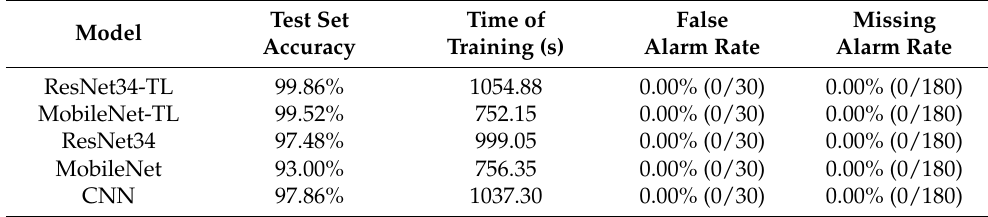
Table 7. Average results for each